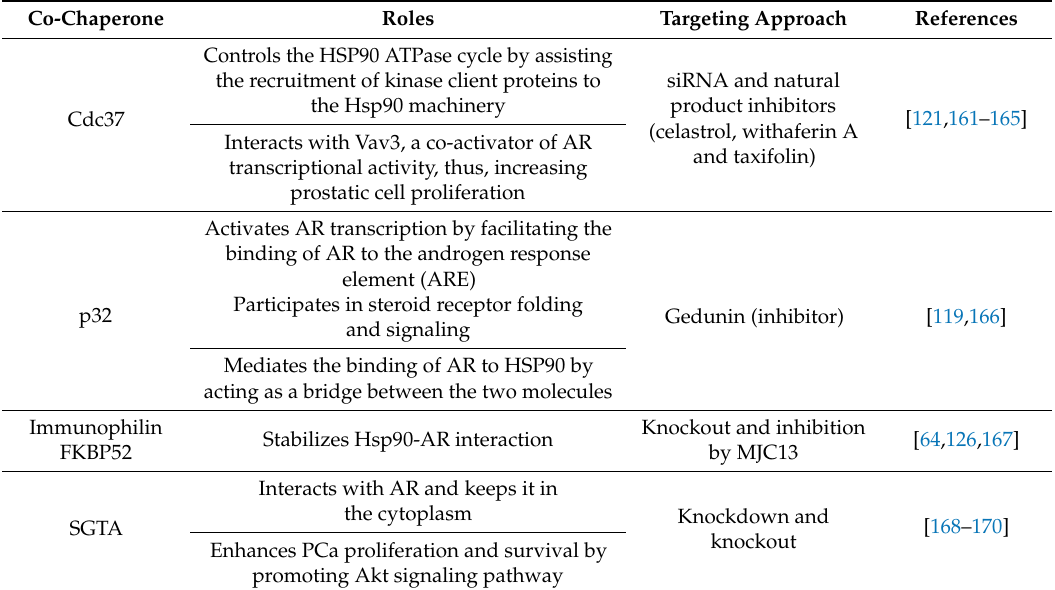
Table 4. Key HSP90 co-chaperones and their involvement in prostate